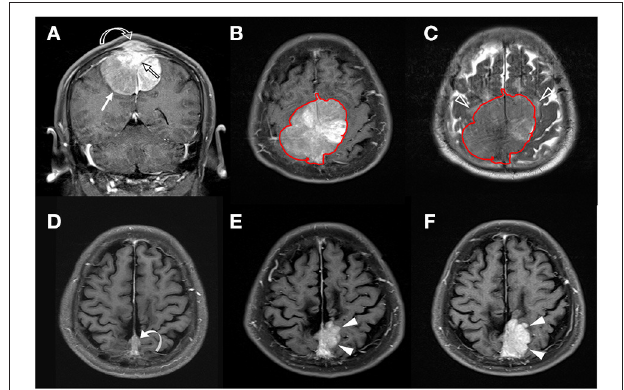
FIGURE 3 | A 58-year-old man with pathologically proven parasagittal meningioma (WHO grade I). (A) Coronal CE T1WI shows an enhancing tumor mass (white arrow) in the midline parasagittal region with invasion into the superior sagittal sinus (SSS) (open black arrow) and adjacent skull bone (open curved arrow). (B,C) The tumor (red outline) is segmented on the axial CE T1WI (B) and then mapped onto the axial T2WI (C) . Mild peritumoral edema (white open arrowheads) is noted on T2WI (C) . The calculated SVM score based on the four selected radiomic features is 0.337. (D) Subtotal tumor resection is performed to preserve the SSS; residual tumor (curved arrow) is noted in the posterior SSS. (E,F) Progressive recurrence of tumor (white arrowheads) was observed in 37 months (E) and 56 months (F) after surgery.